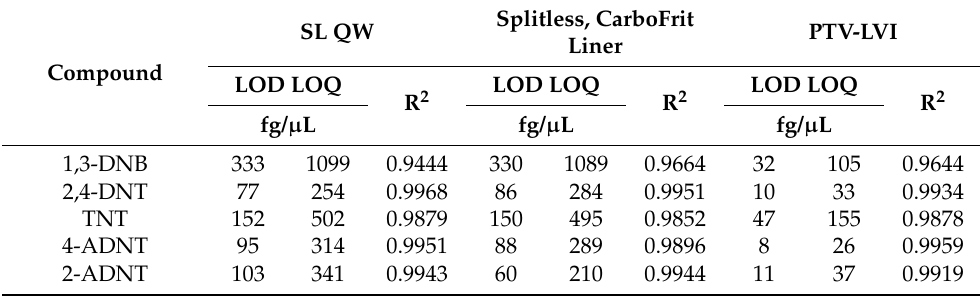
Table 3. Detection and quantification limits of the applied methods. On column, volumes are 1 µ L for the splitless and 5 µ L for the PTV large-volume